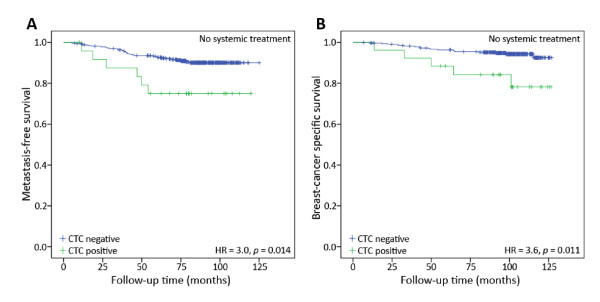
Kaplan-Meier plot of metastasis-free survival (A) and breast cancer specific survival (B) in patients who did not receive systemic adjuvant treatment (n = 367). The CTC-positive patients had a poorer MFS and BCSS than CTC-negative patients (MFS HR = 3.0, 95% CI = 1.2 to 7.1, P = 0.014; BCSS HR = 3.6, 95% CI = 1.3 to 9.6, P = 0.011).